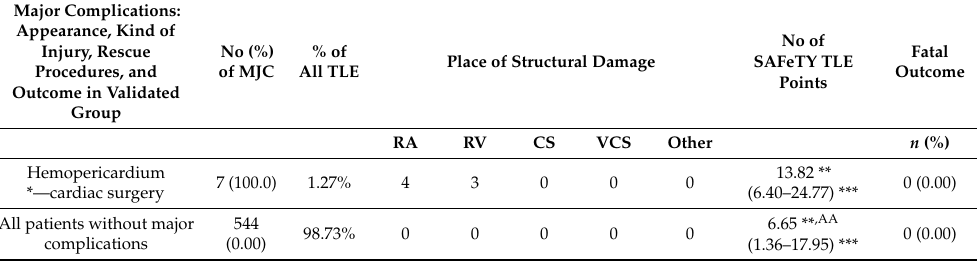
Table 5. Major complications with SAFeTY TLE points in the validation